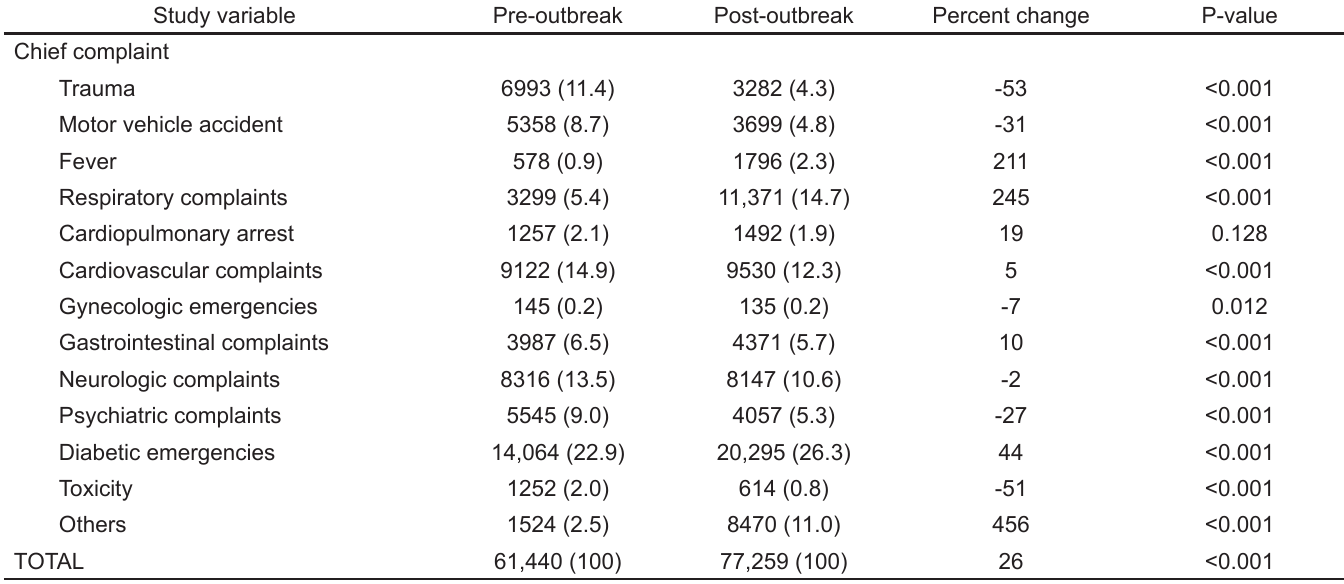
Table 2. Comparison of chief complaints and vital signs in emergency medical services dispatches before and after the start of the COVID-19